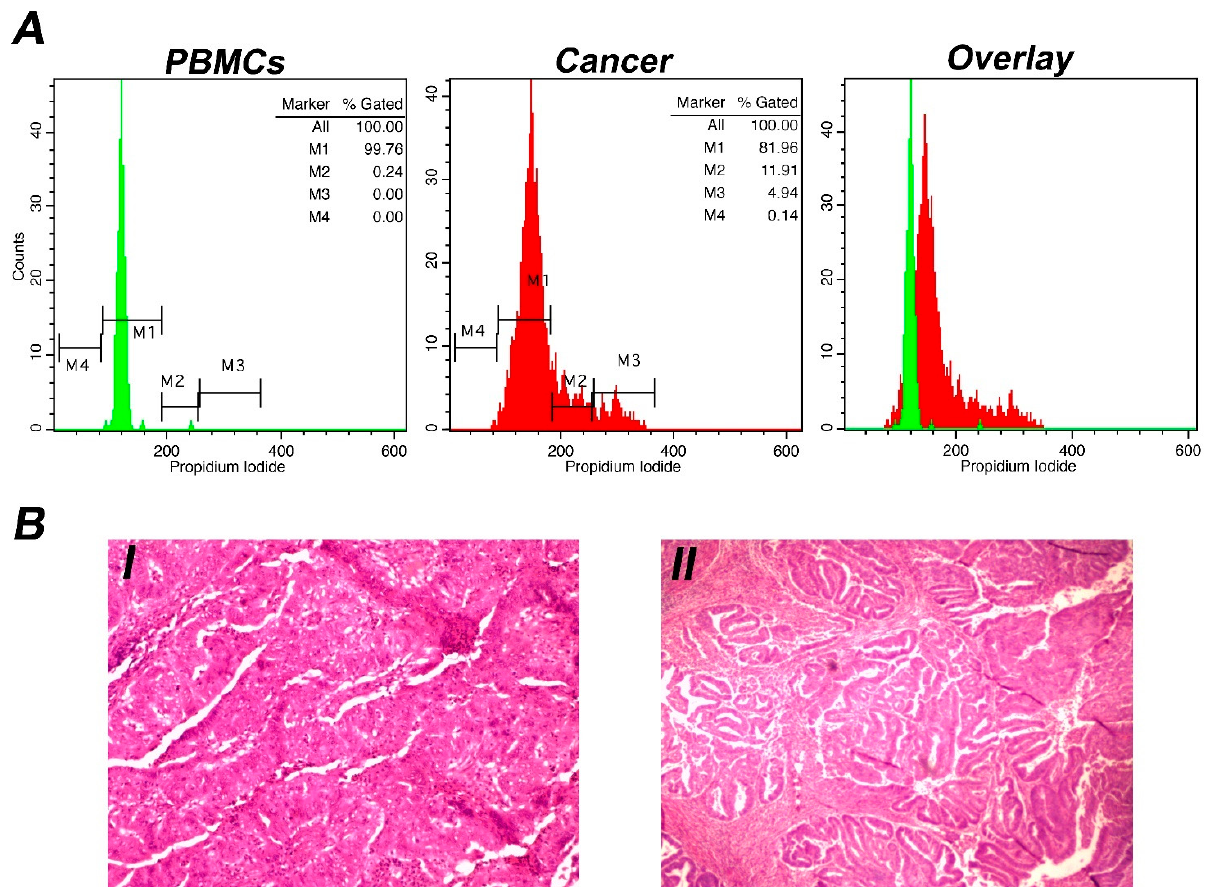
Figure 1. Analysis by iFC and pathology assessment of a representative case of endometrial cancer: ( A ) DNA content and cell-cycle distribution analysis using iFC: Cancer cells acquired during surgery (presented in red histograms) and normal (control) PBMCs (presented in green histograms) were stained with propidium iodide, and the quantity of DNA was analyzed using flow cytometry. Markers M1, M2, and M3 and M4 represent the G1, S and G2/M cell-cycle phases, respectively. Marker M4 represents cells in subG1 (indicative of cell death). The percentage of cells that correspond to each phase is shown in the upper right part of the histogram. The G0/G1 peak from the PBMC sample was used as a reference for DNA index calculation. The presented case is hyperploid, with a DNA index of 1.2 (the G0/G1 peak of cancer cells in red is discernible from that of normal cells in green in the overlaid histogram). Tumor index (i.e., percentage of proliferative cells) was calculated at ~17%. ( B ). Pathology evaluation: Ovarian cancer cells stained with hematoxylin/eosin are presented at 40x (I) and 200x (II) magnification. A moderately differentiated tumor (grade II) is recognized. Receiver operating characteristic (ROC) curve analysis was used to evaluate both the sensitivity and specificity of the technique, as well as to estimate the ideal cutoff value for the discrimination of normal tissue from cancer tissue (Figure 5). The optimal cutoff value to delineate the status of tumor tissue is a tumor index of more than 6.5% (or a G0/G1 percentage of less than 94.5%), resulting in 100% sensitivity and 90.5% specificity (Table S4), thus elevating the accuracy of our assay to